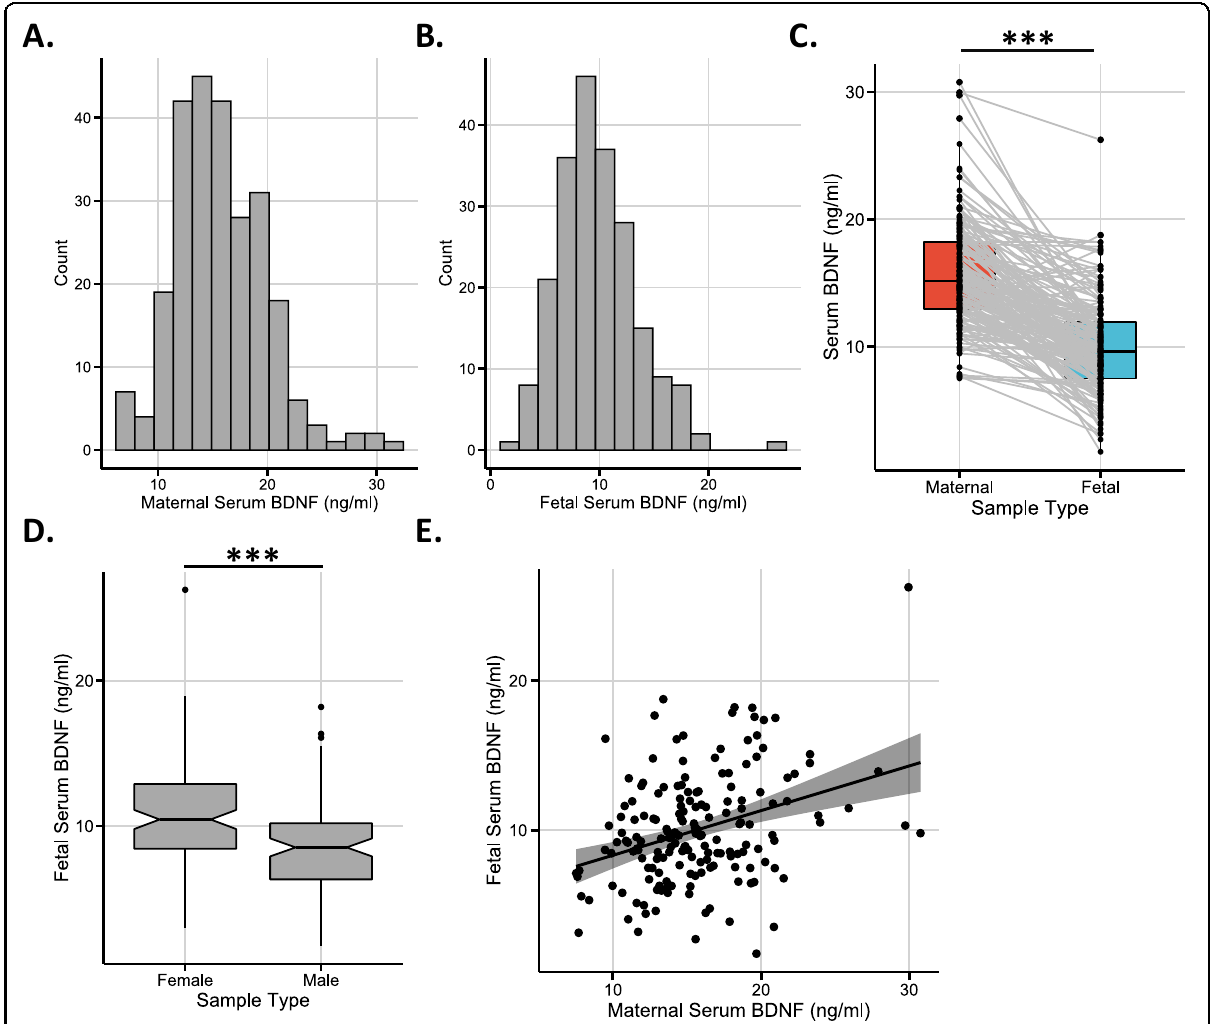
Fig. 1 Characterization of serum BDNF levels in maternal and fetal serum. Distribution of serum BDNF values in maternal A and fetal B samples. C Comparison of serum BDNF values between matched maternal and fetal samples (Wilcoxon signed-rank test, P < 2.20e-16, r = − 0.575, n = 173 maternal – fetal pairs). Gray lines connect maternal – fetal pairs. D Fetal serum BDNF comparison between female and male infant cord blood serum. *** P < 0.001 between female ( n = 115) and male ( n = 97) serum samples. After controlling for potential confounding variables (hypertension, gestational diabetes, maternal BMI at booking, smoking, or alcohol at any point in pregnancy, strenuous exercise and prescription of antidepressants) in a linear model, male fetal sex was associated with a decrease in serum BDNF of 2.20 ng/ml (95% con fi dence intervals (CI): − 3.21, − 1.19, P = 2.63e- 5) compared to females (median (IQR) — female: 10.45 (4.45); male: 8.53 (3.86) ng/ml). Boxplot values indicate the following: Box boundaries, 25% and 75% quartiles; mid-line, median; notch, 1.58 × interquartile range (IQR)/sqrt ( n ); whiskers, highest and lowest values within 1.5 × IQR of the box boundary; outliers, values outside the whiskers. Unadjusted vs. adjusted model shown in Supplementary Table 2. E Relationship between paired maternal and fetal serum BDNF levels ( r = 0.290, P = 1.09e-04, n = 173 pairs, Spearman ’ s rank correlation; 95% con fi dence intervals are shaded in gray). In a linear model analyzing this relationship whilst controlling for potential confounding variables (see “ Methods ” ), a 1 ng/ml increase in maternal serum BDNF corresponded to a 0.385ng/ml increase in fetal serum BDNF (95% CI: 0.244, 0.526, P =